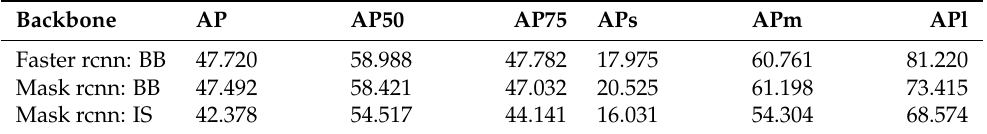
Table 5. Summary of object detection performance reported as Average Precision (AP) at different IoU thresholds, using different backbones."BB” denotes the bounding box-based approach, while “IS” denotes the instance segmentation-based